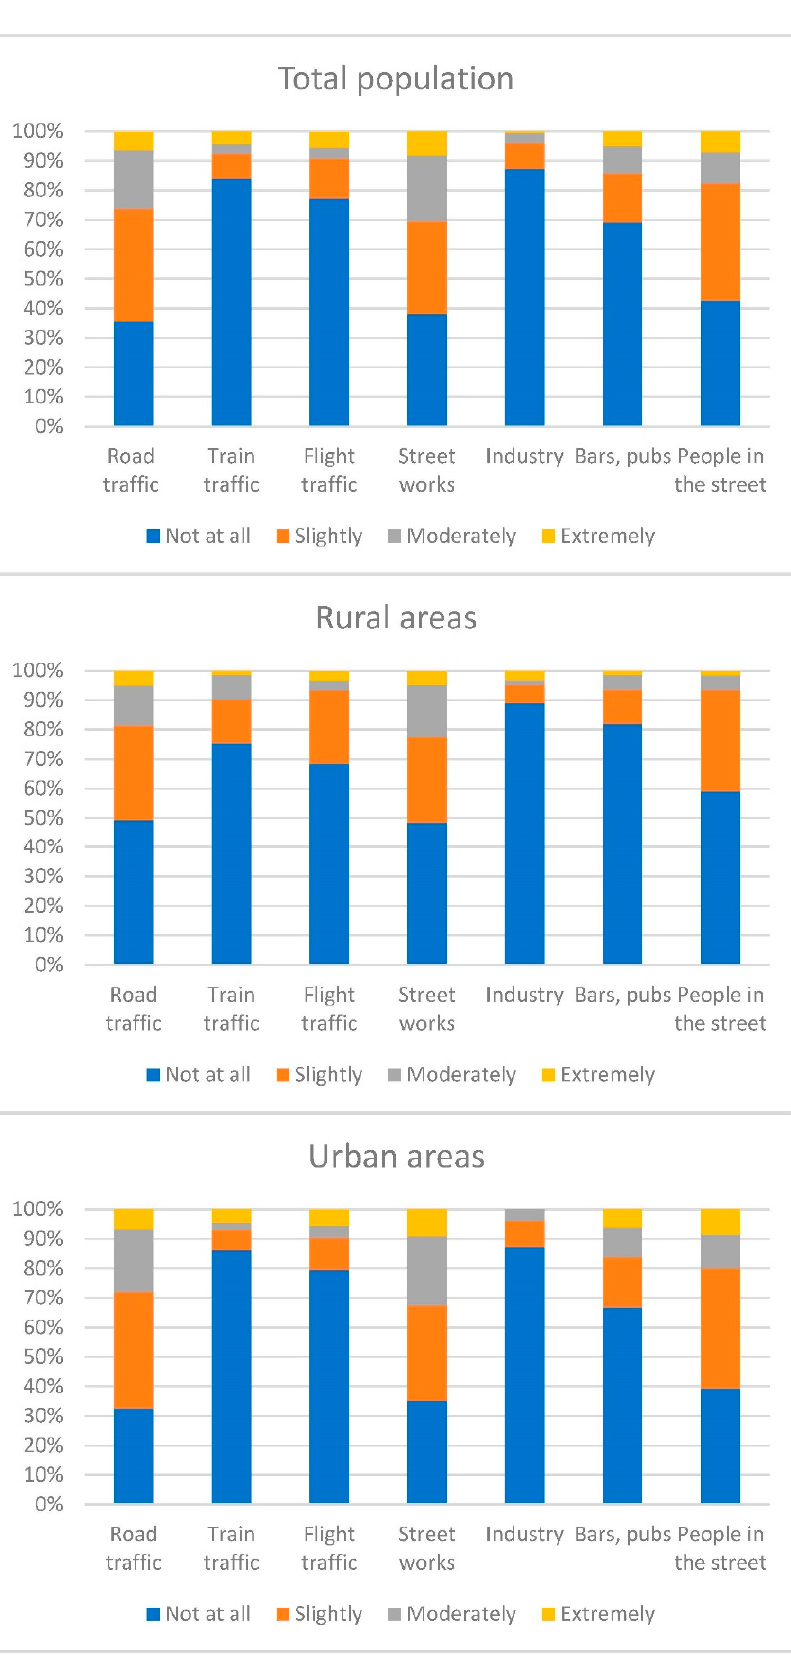
Figure 1. Percentage of participants who reported disturbance from external sources of noise in rural and urban areas during the previous 3 months.